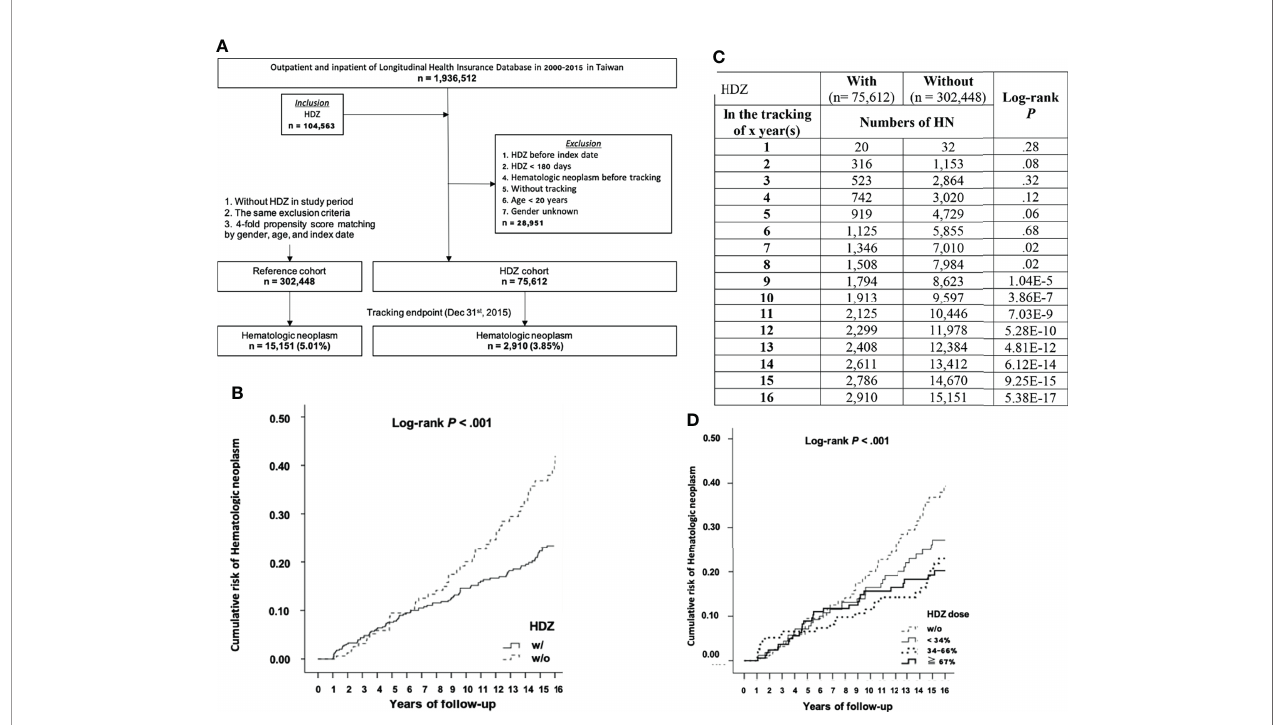
FIGURE 3 | A cohort study focusing on the association of HN incidence reduction with HDZ. (A) A fl owchart showing sample-subject selection for the cohort study. (B, C) The Kaplan – Meier curve for cumulative incidence of HN with log-rank test. (D) A Kaplan – Meier curve for cumulative incidence of HN strati fi ed by HDZ dose (% to DDD set as 100 mg per day) with the log-rank